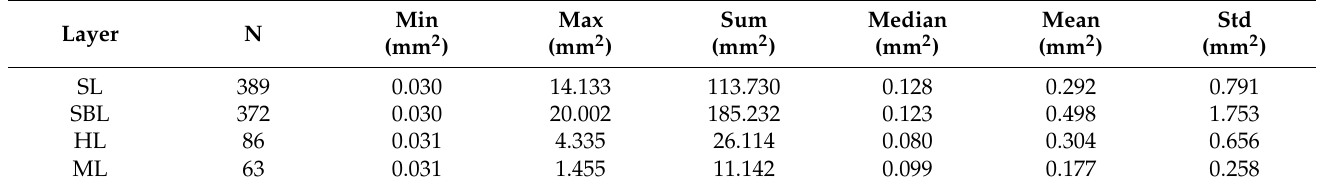
Table 2. Descriptive statistics of the size of particles in each layer. Size is expressed as observed cross- sectional area of particles. N represents the number of particles sampled in each layer, i.e., sample